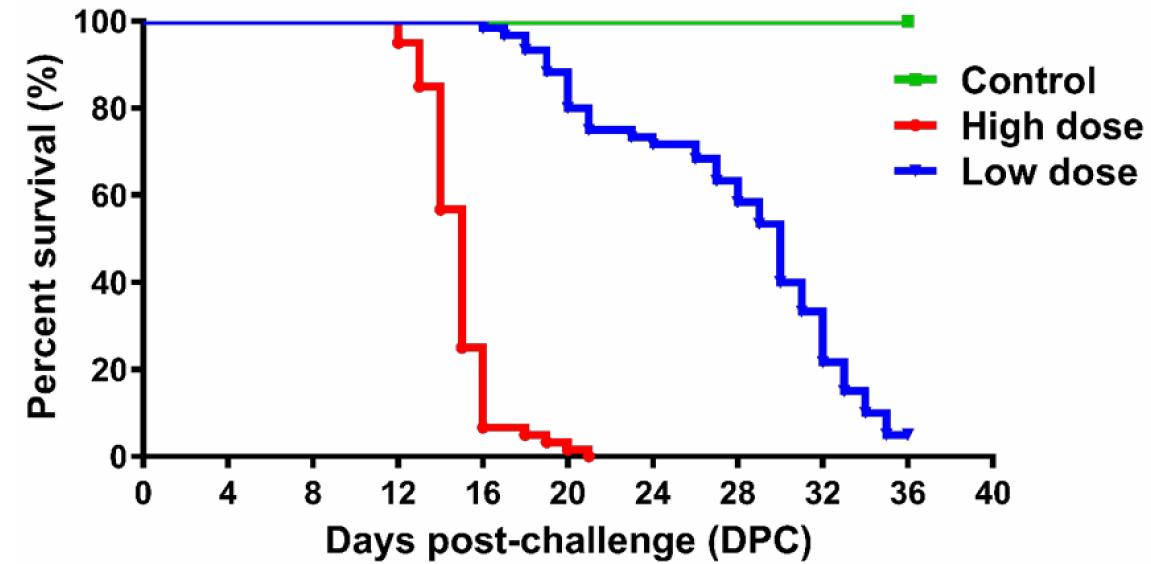
Figure 2. Kaplan-Meier survival plot of fish challenged with 2 × 10 2 TCID 50 /mL ISAV (high dose group; HDg), 2 × 10 4 TCID 50 /mL ISAV (low dose group; LDg) or virus-free L-15 cell culture medium (negative control; Cg) in the three observational tanks (T2: high viral dose tank; T4: low viral dose tank; and T5: negative control